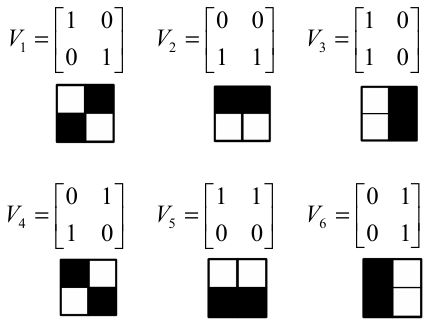
Figure 5. Each pixel of I is replaced by one of these blocks to generate two secret shares.